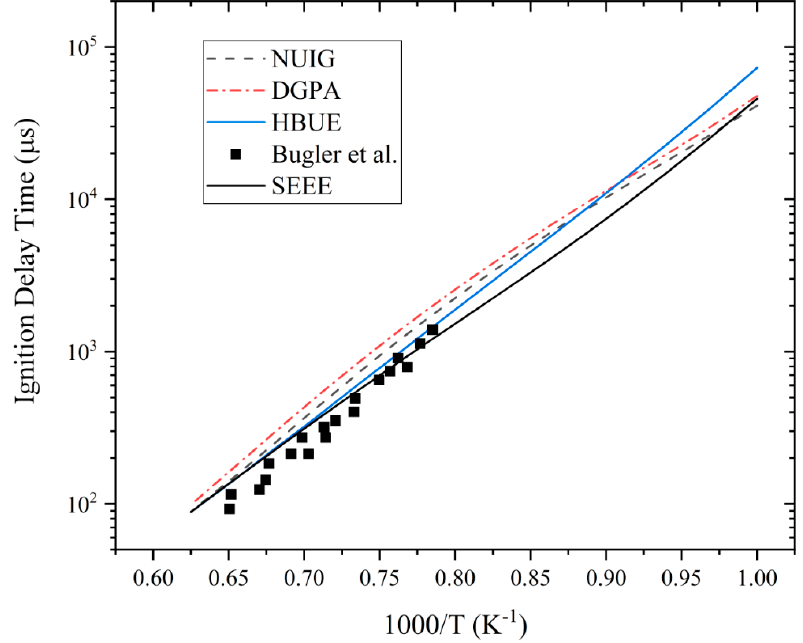
Figure 9. Comparison of the ignition delay times between NUIG, DGPA, HBUE, SEEE, and experimental data at an equivalence ratio of 2.0.